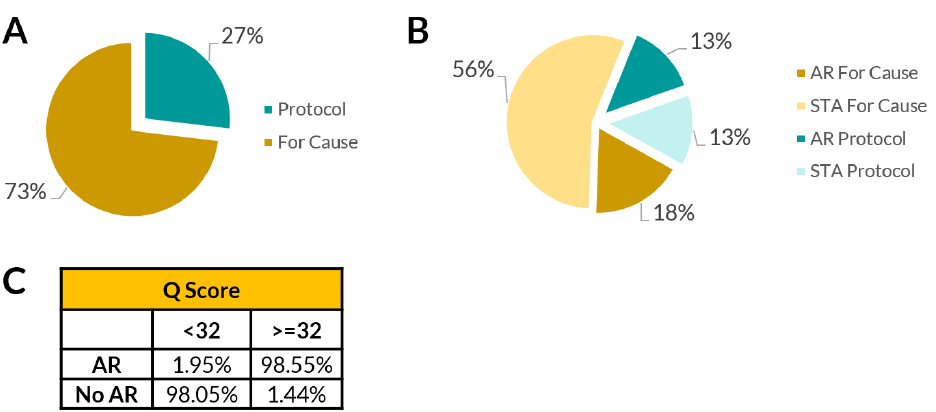
Figure 7. The urine QSant assay and Q-Score can help reduce unnecessary renal biopsies. ( A ) The study cohort contains a total of 163 for-cause biopsies, of which 124 had Q-Scores below the rejection threshold of 32. Of the 60 protocol biopsies, 30 had a score below the rejection threshold of 32. The breakdown of di ff erent biopsy diagnoses paired with the sample is shown in the figure as percentages. ( B ) In this study cohort, if physicians had Q-Scores on hand, the test results would have impacted their decision to not order biopsy for 69% (154 / 223) of the time. ( C ) Accuracy of biopsy (for-cause vs. protocol) and the Q-Score (score < 32 vs. score ≥ 32) for classifying AR and STA using Ban ff classification confirmed biopsies as reference standard.